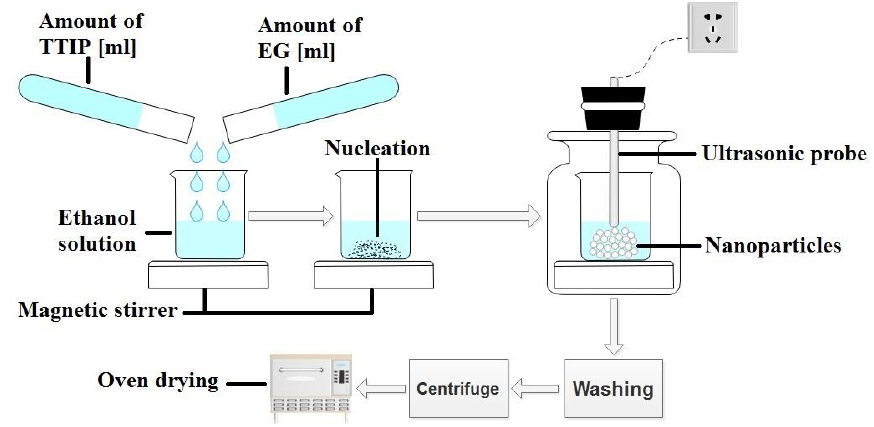
Figure 1. Graphical representation of experimental setup for the synthesis of TiO 2